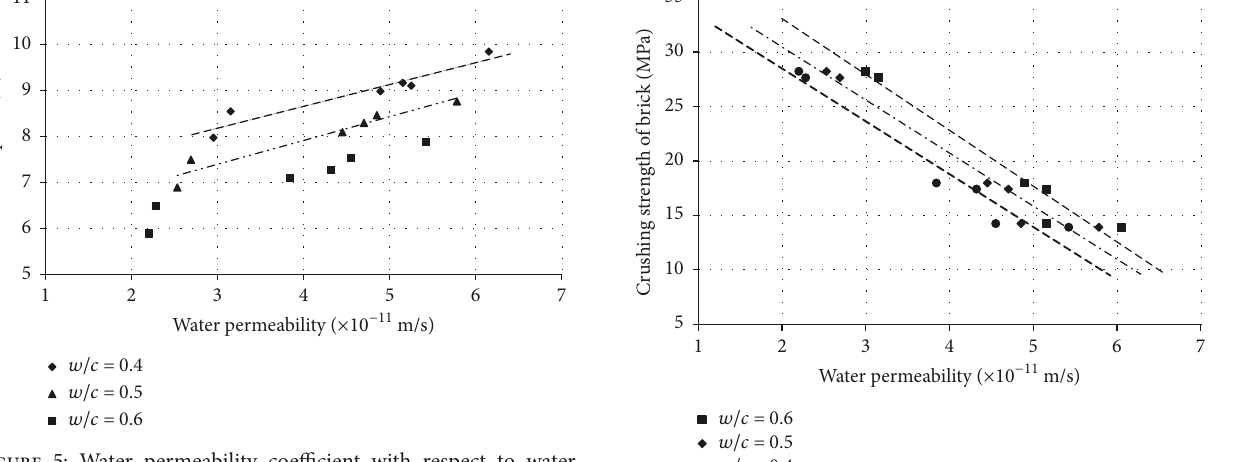
Figure 5: Water permeability coefficient with respect to water absorption of hardened concrete.